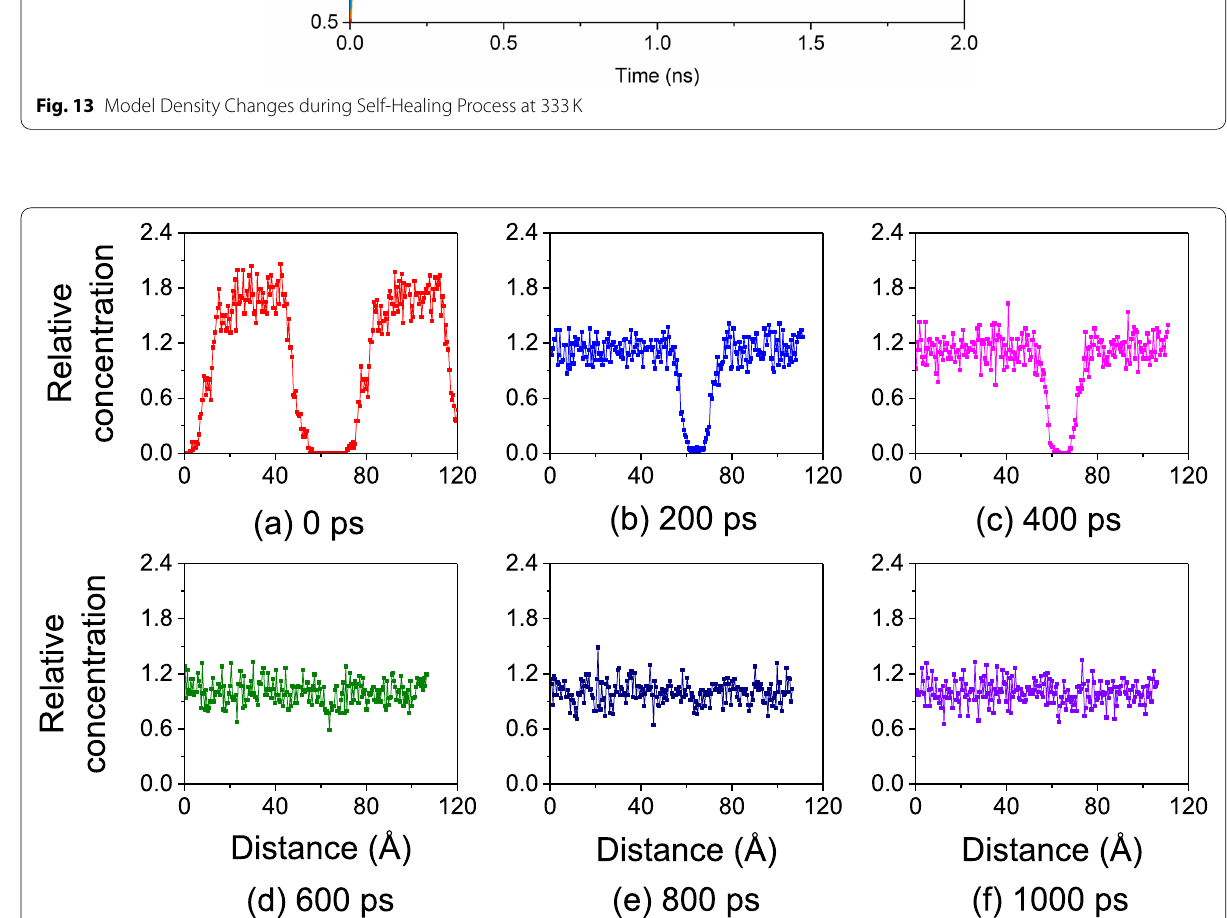
Fig. 14 Relative Concentration Distribution of Nano-Crack Model in the z-direction at 298 K at Difference Running Time (from 0 to 1000